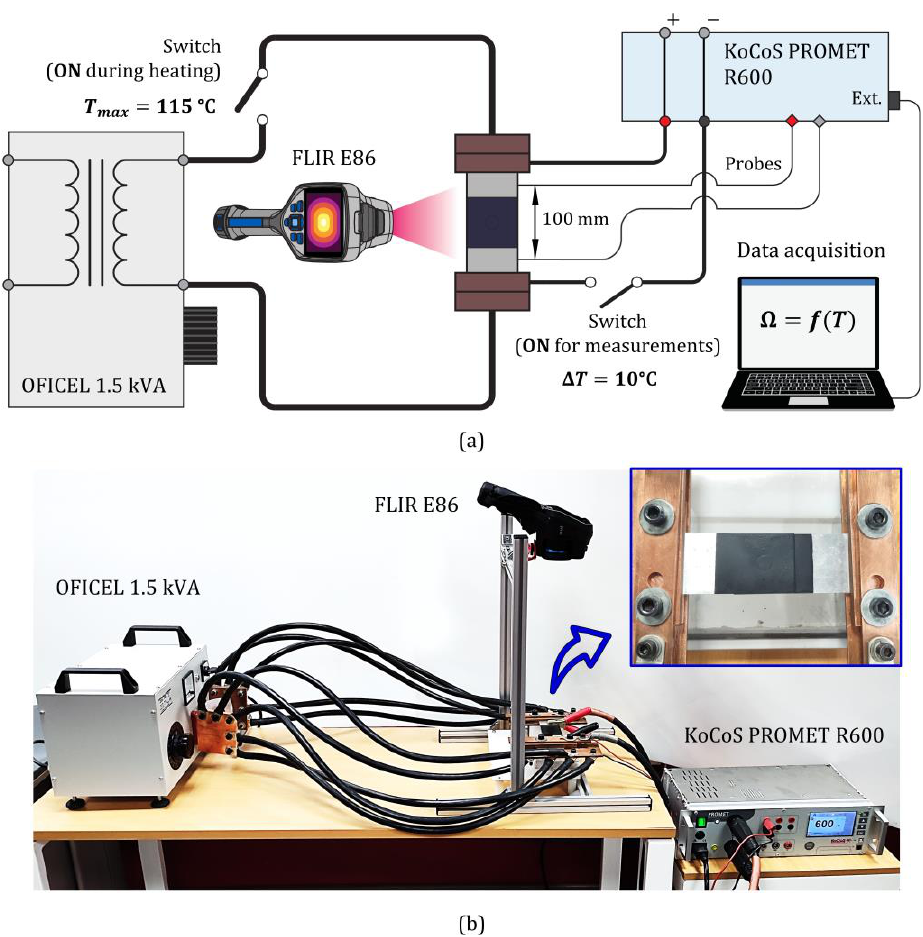
Figure 3. ( a ) Layout and ( b ) photograph of the experimental apparatus that was utilized to perform the thermo-electrical characterization of the materials and joints.